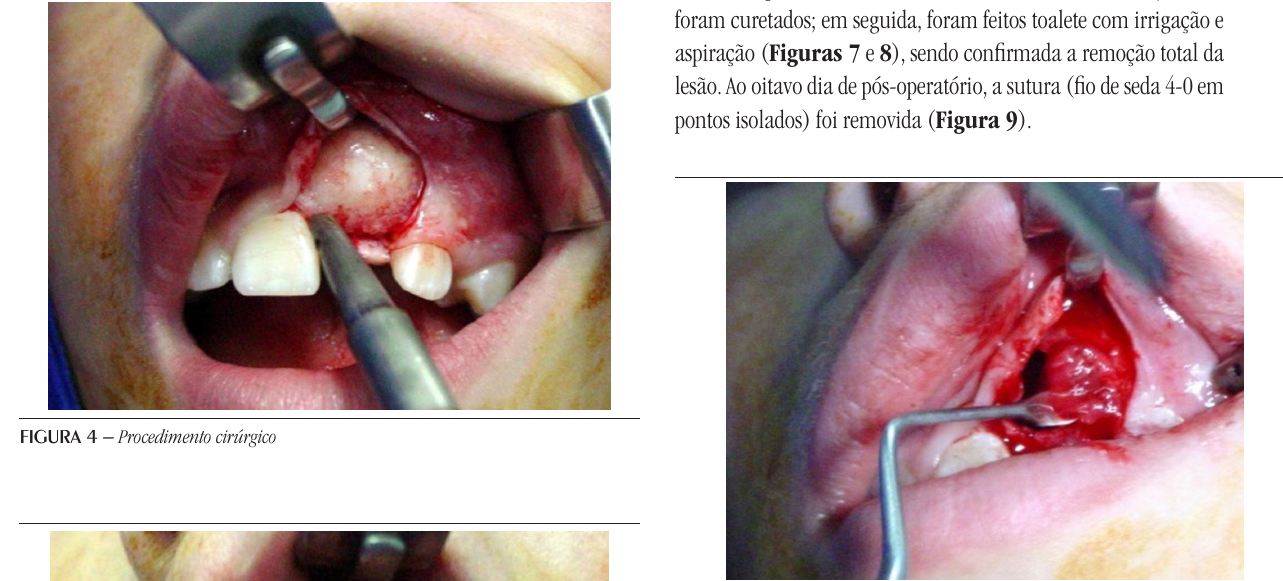
FIGURA 7 – Procedimento cirúrgico